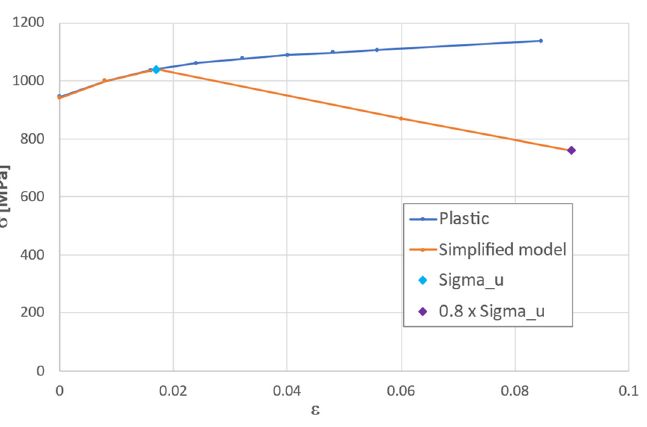
Figure 9. Modification of the true stress–true strain curve to account for the material degradation.